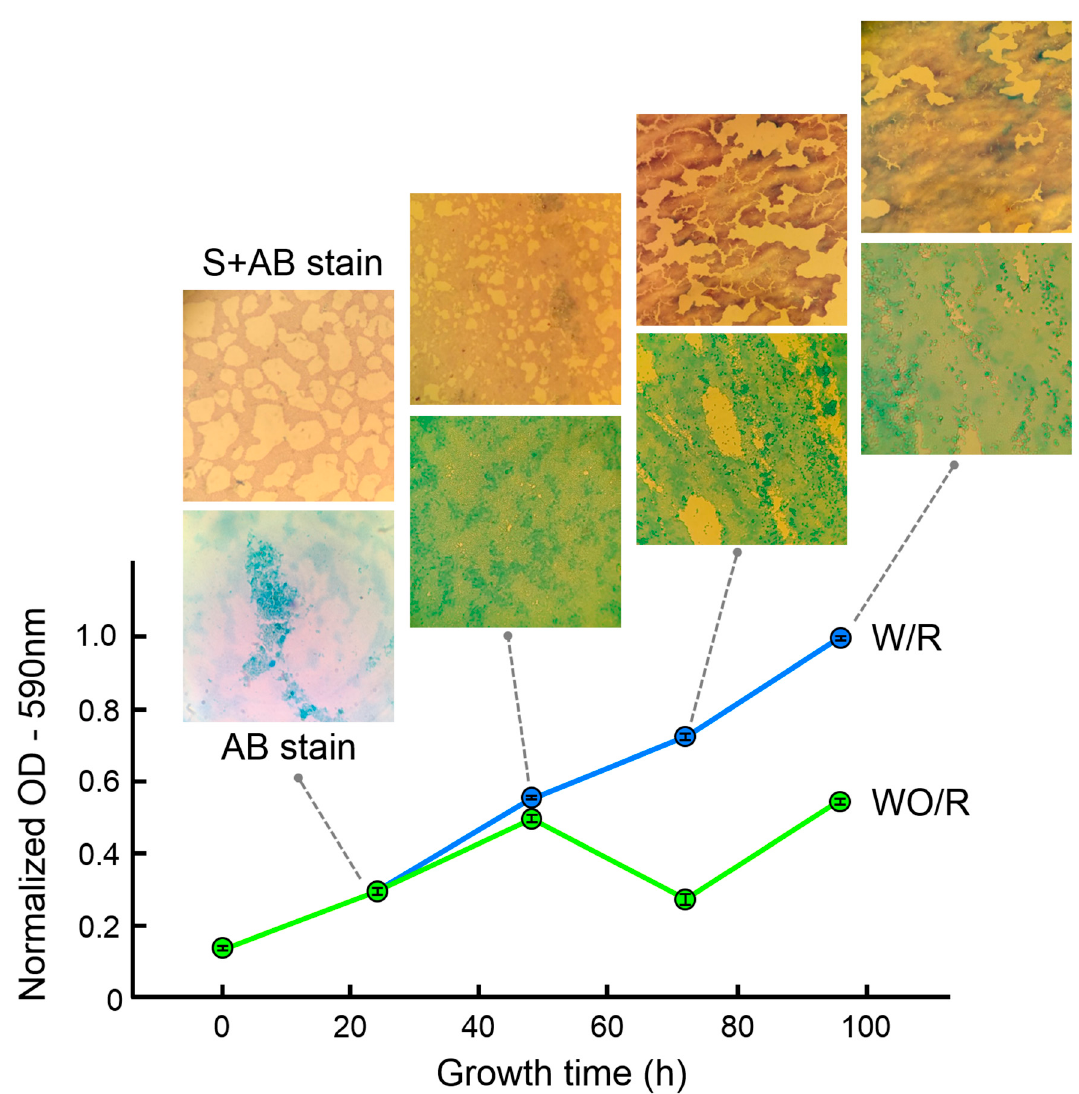
Figure 1. Optical density (OD) measurements and optical micrographs of a staining test of E. cloacae biofilms grown on glass as a function of time. The response of biofilm under no-media replacement incubation conditions (WO/R) and media replacement incubation conditions (W/R) is depicted. Corresponding staining test for each time is included (for optical micrographs of staining test for WO/R conditions see supplementary Figure S3).